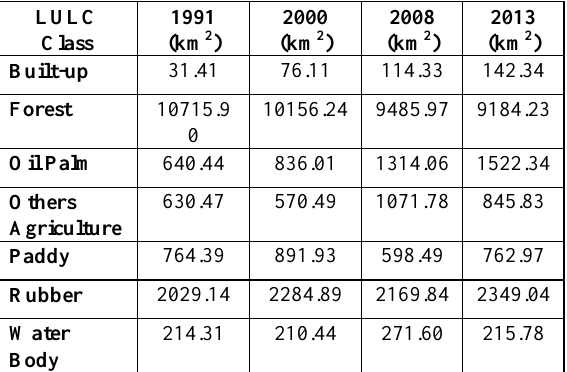
Table 2. LULC distribution in Kelantan from 1991 to 2013